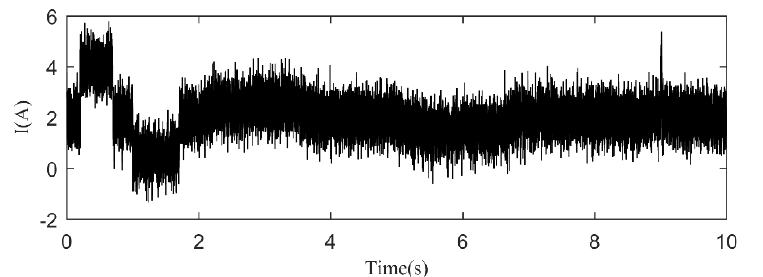
Figure 11. Photovoltaic signal simulation diagram under the noise of SNR 5.